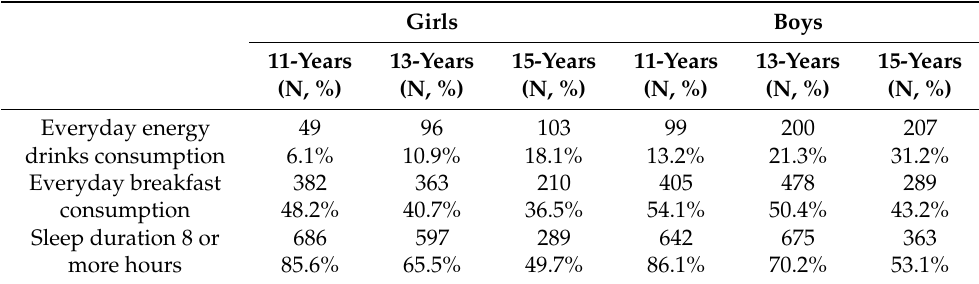
Table 2. Frequencies of everyday energy drinks consumption, everyday breakfast consumption and sufficient sleep duration stratified by age and gender (HBSC-study, Slovakia 2018, 11–15 years old, N = 8405).